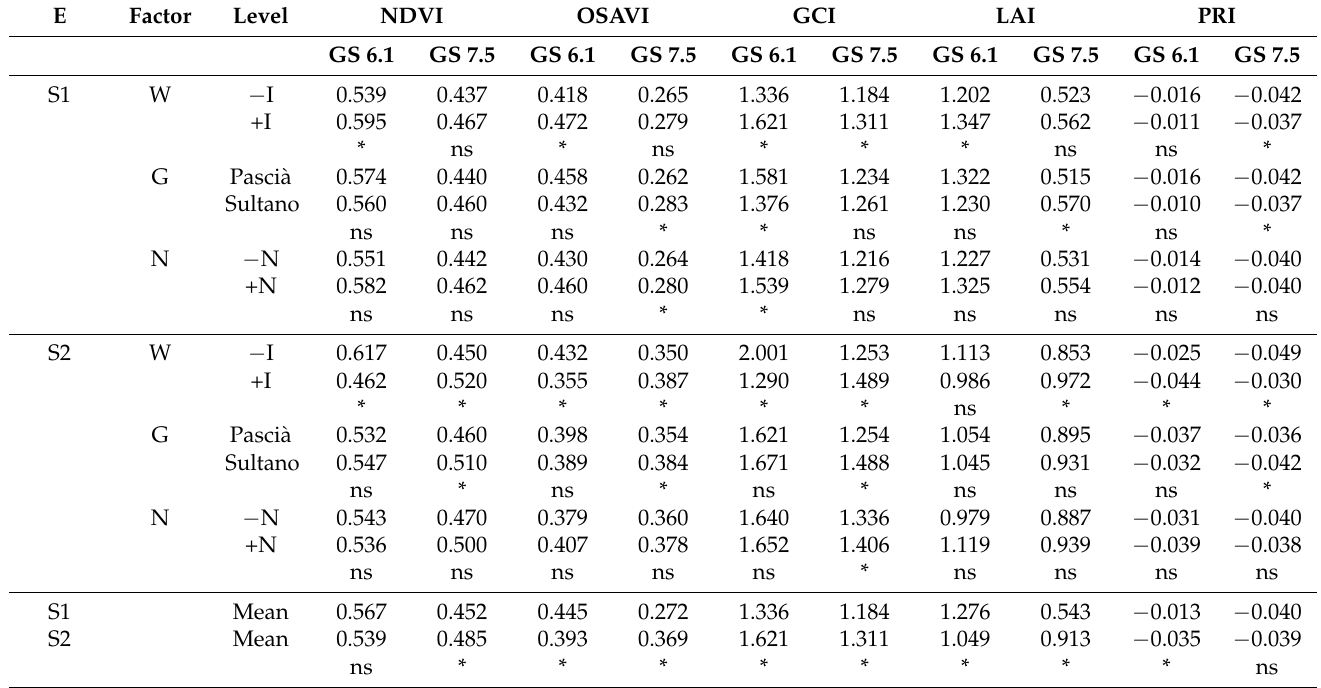
(Table 6). Here, NDVI, OSAVI, and EVI-LAI are descriptors of biomass vigor and crop development, while GCI is generally considered an indicator of leaf chlorophyll content and PRI of plant stress. Table 6. Agronomic performance, in terms of yield, water use efficiency, and yield components of Pasci à and Sultano chickpea varieties grown under two water regimes and two N